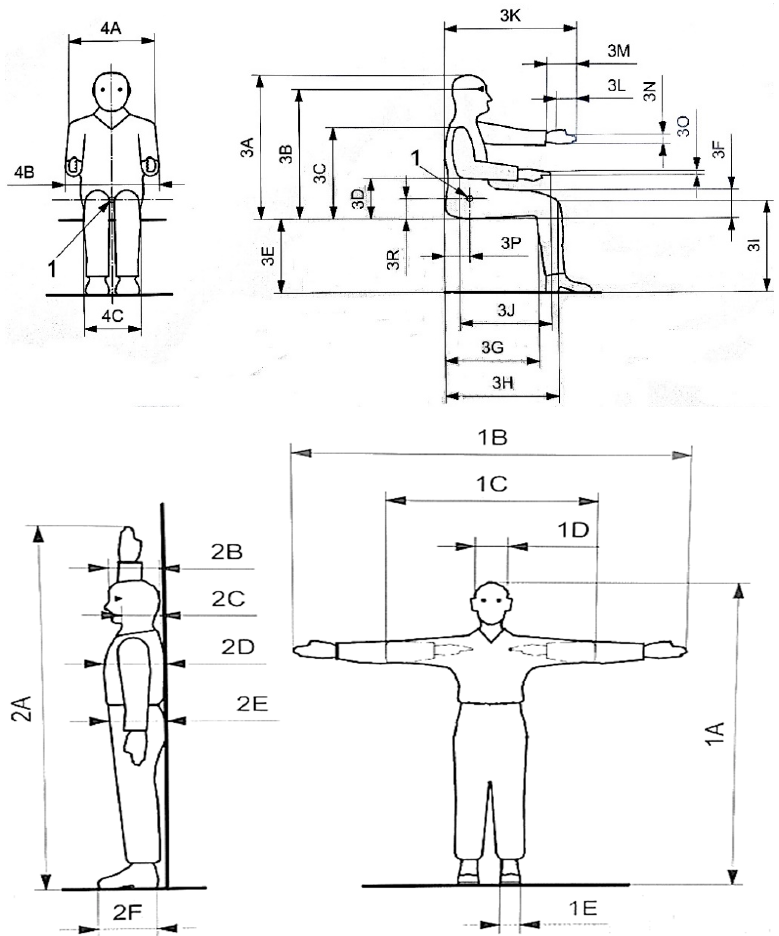
Forests 2022 , 13 , x FOR PEER REVIEW Figure 1. Anthropometric dimensions defined by the EN ISO 3411 standard. Figure 1. Anthropometric dimensions defined by the EN ISO 3411 standard. Table 1. Minimum chainsaw handle clearances and sizes adapted from [23] with permission from International Labour Office, 1978, and Figure 1.